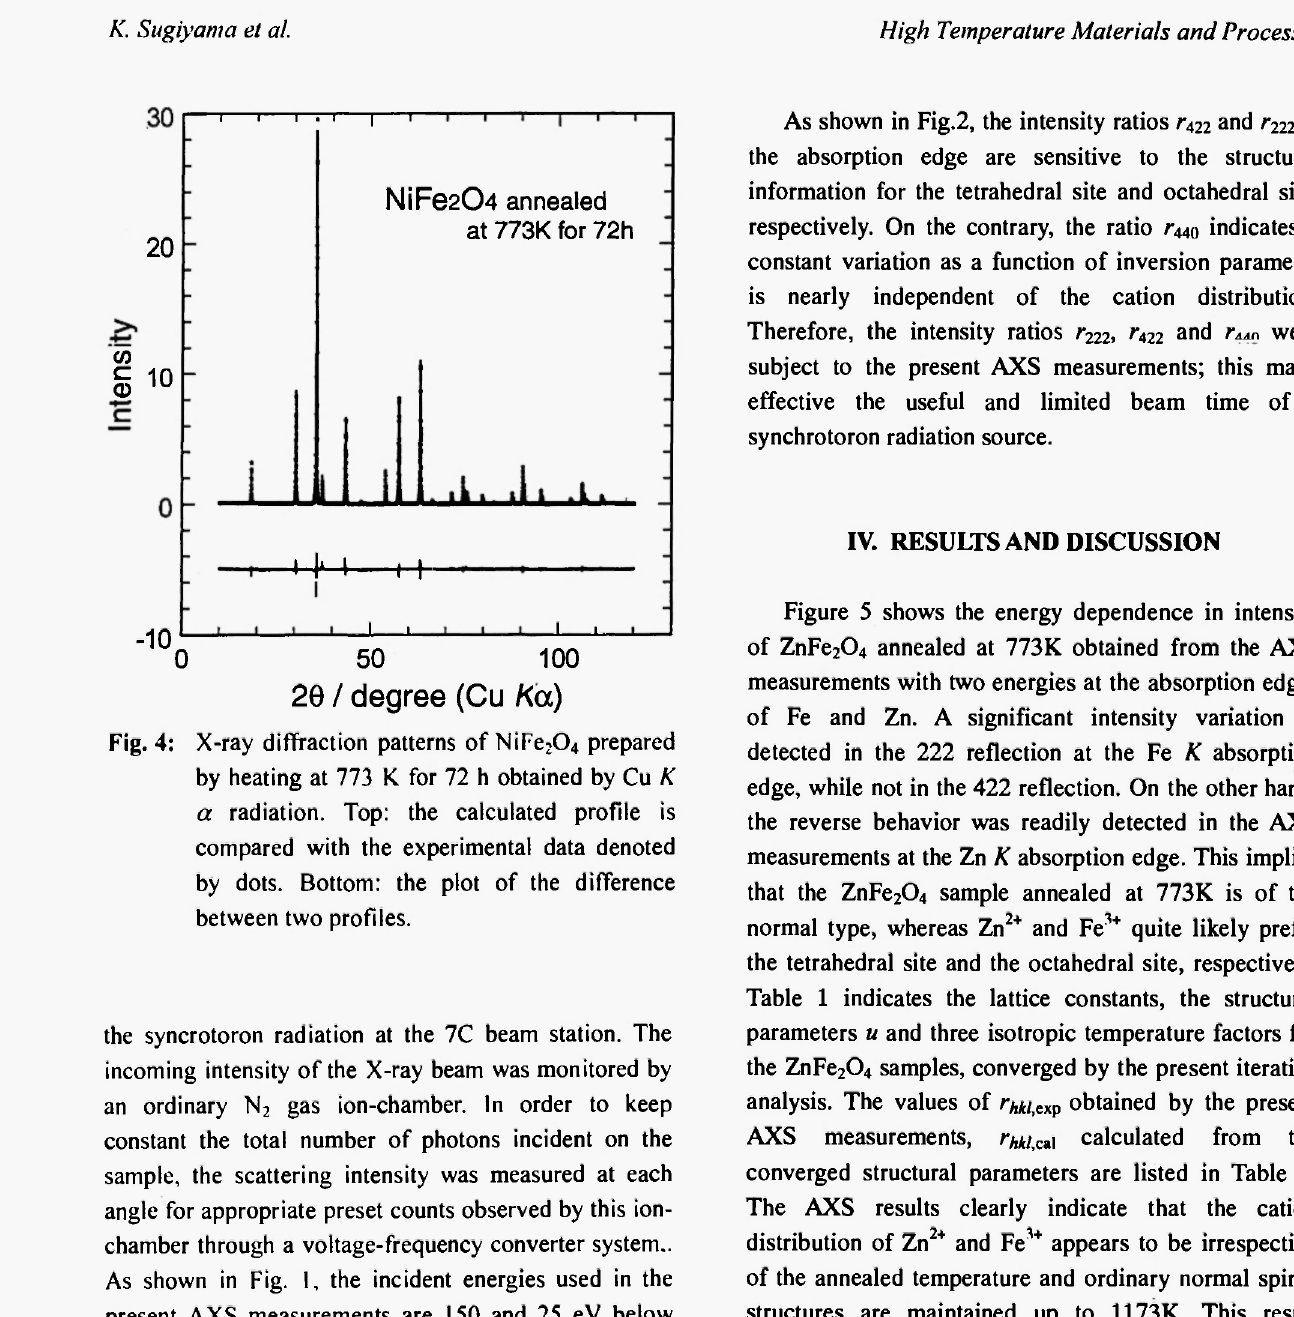
Fig. 4: X-ray diffraction patterns of NiFe by heating at 773 Κ for 72 h obtained by Cu Κ a radiation. Top: the calculated profile is compared with the experimental data denoted by dots. Bottom: the plot of the difference between two